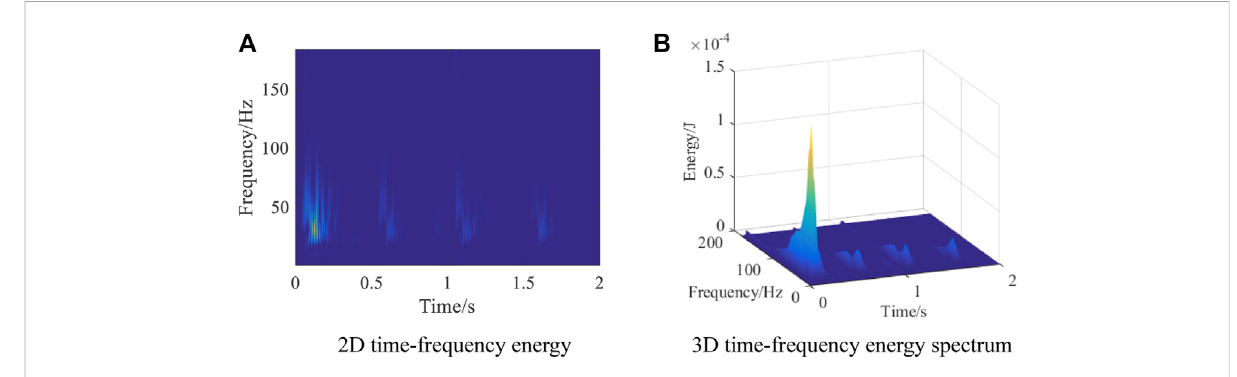
FIGURE 11 Time frequency energy diagram of continuous wavelet transform for blasting vibration